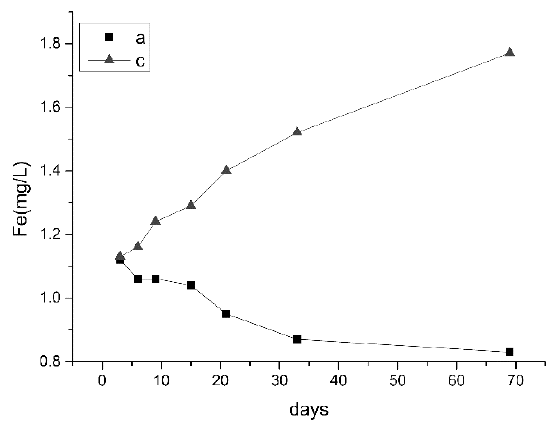
Figure 5. Ferric ion concentration curves of sample liquids (a and c, respectively, represent the ion concentration in the liquids with oil shale heated to 300 °C and unheated oil shale).